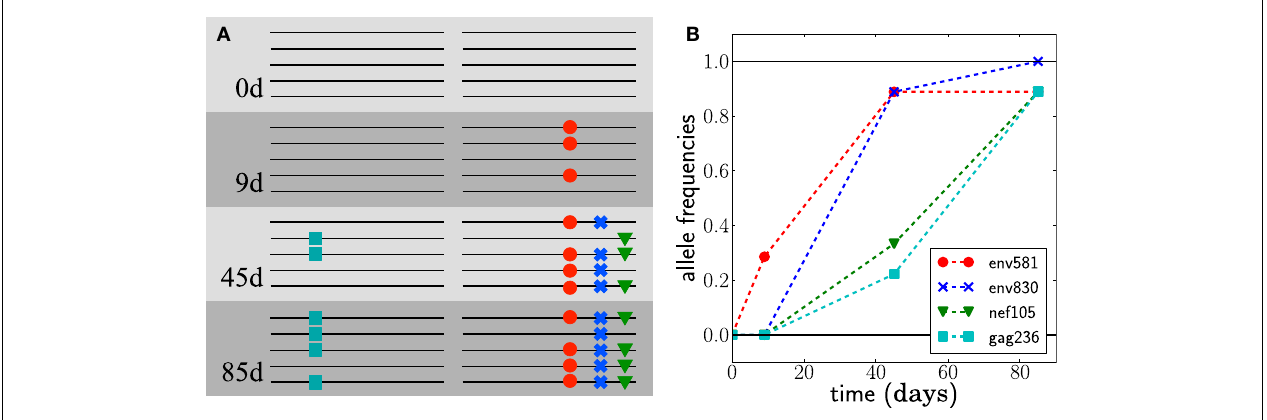
at different times; see (7, 8) for the actual data. (B) shows the frequencies of the mutations in samples of size 7 at day 9 and size 9 at days 45 and